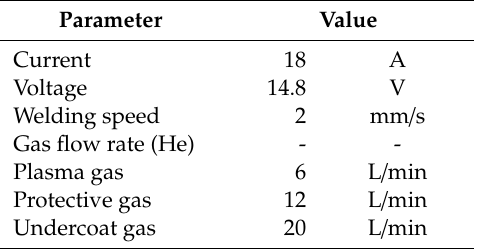
Table 2. Welding parameters used in the manufacturing of samples [5].